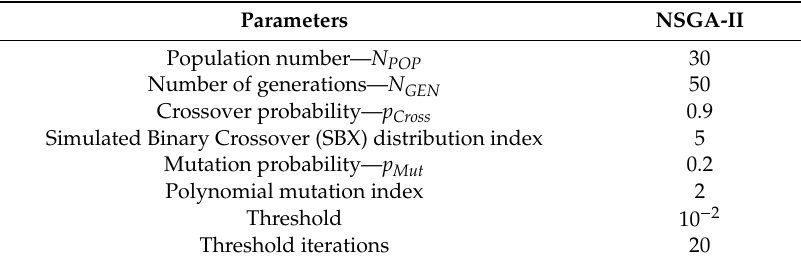
Table A1. Parameters used in the NSGA-II algorithm.